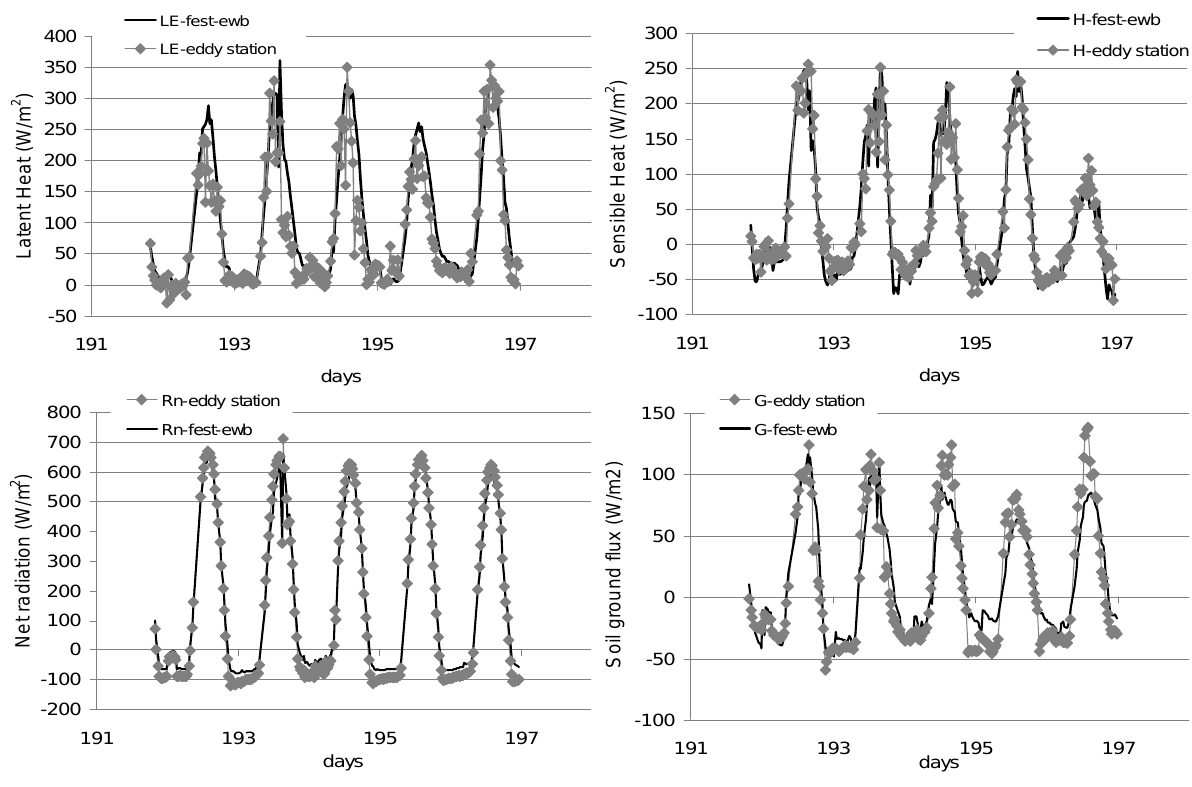
Fig. 2. Comparison between simulated and measured energy